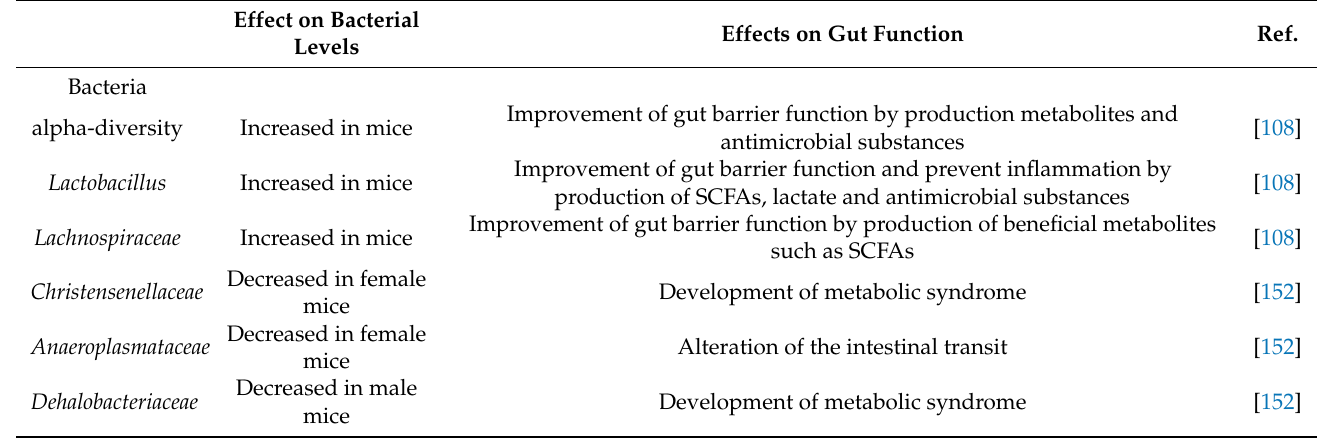
Table 4. Effects of nicotine on gut microbiota and their